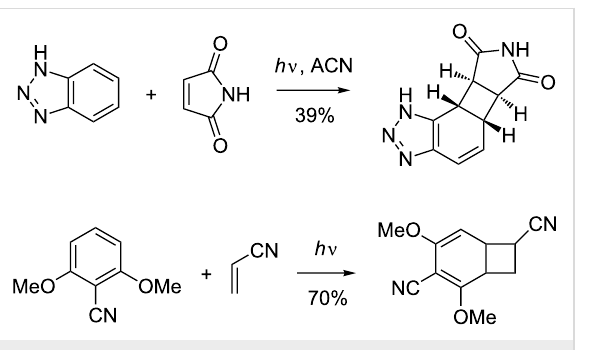
Scheme 26: Stable [2 + 2]